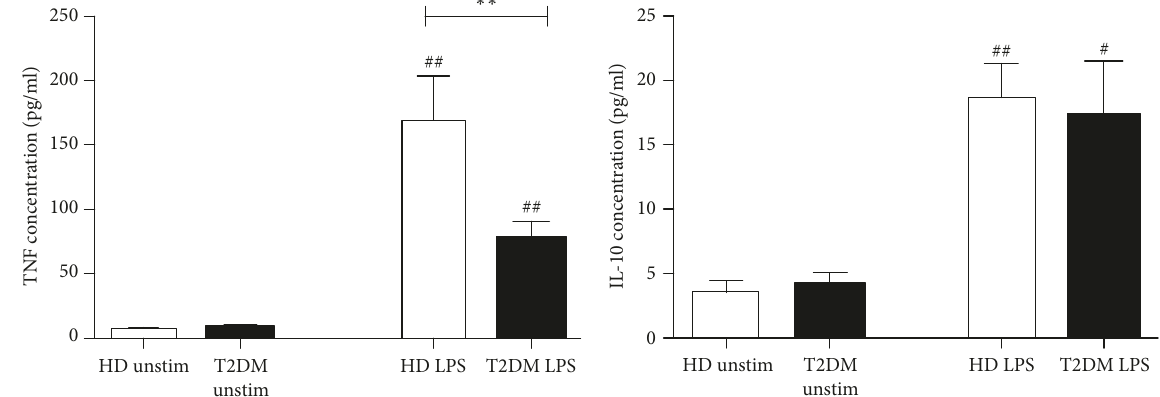
Figure 2: Concentrations of TNF 𝛼 and IL-10 in supernatants after cultivation of whole blood from healthy donors (HD, white bars) and type 2 diabetic (T2DM, black bars) subjects with medium alone (unstimulated) or 100ng/ml LPS for 24 hours. Results are presented as mean ± SE. # 𝑝 < 0.05 ; ## 𝑝 < 0.01 versus unstimulated cultures; ∗∗ 𝑝 < 0.01 versus healthy